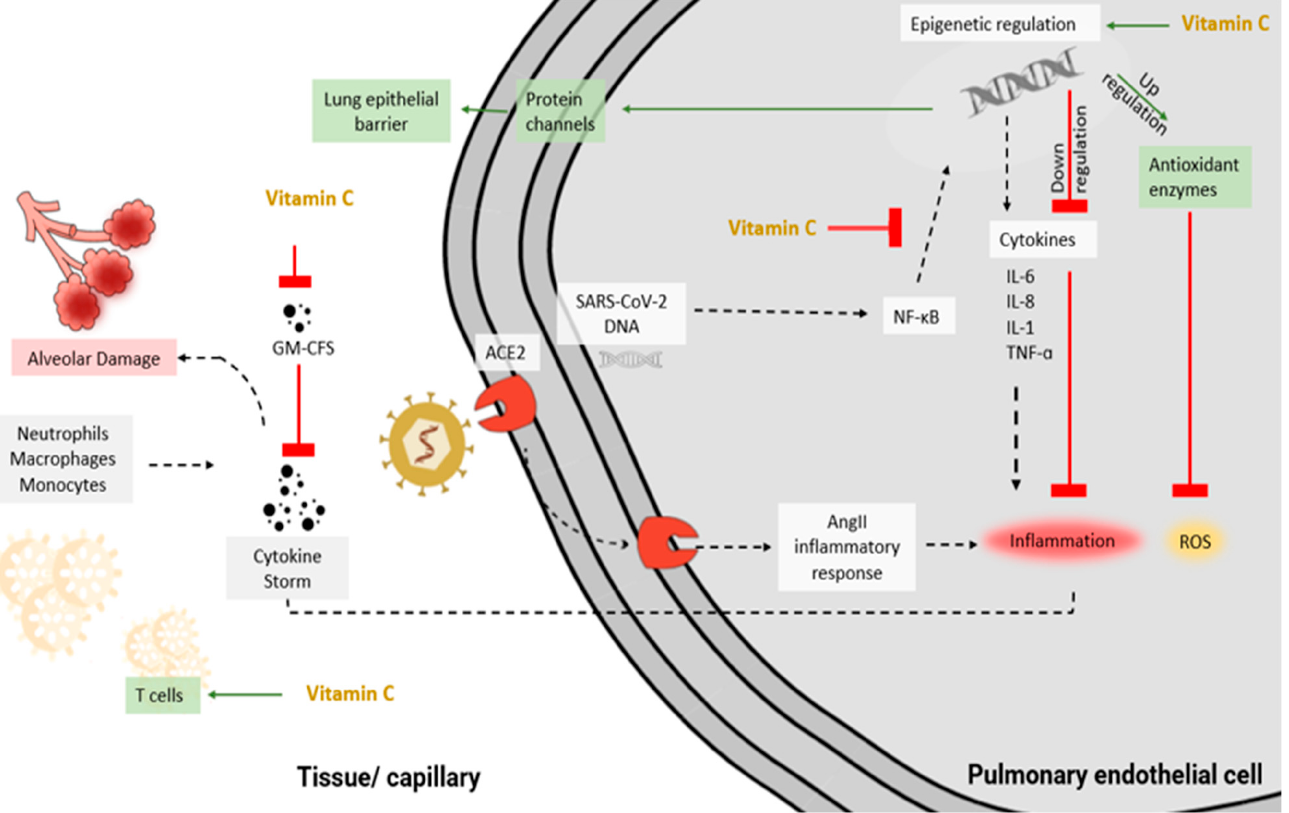
Figure 1. Anti-inflammatory and anti-viral mechanisms of ascorbic acid in SARS-CoV-2 infection. Abbreviations: ACE2, Angiotensin-converting enzyme 2; AngII, Angiotensin-II; GM-CFS, Granulocyte–macrophage-colony-stimulating factor; IL, Interleukin; NF- κ B, Nuclear factor kappa-B; ROS, Reactive oxygen species; TNF- α , Tumor necrosis factor-alpha.